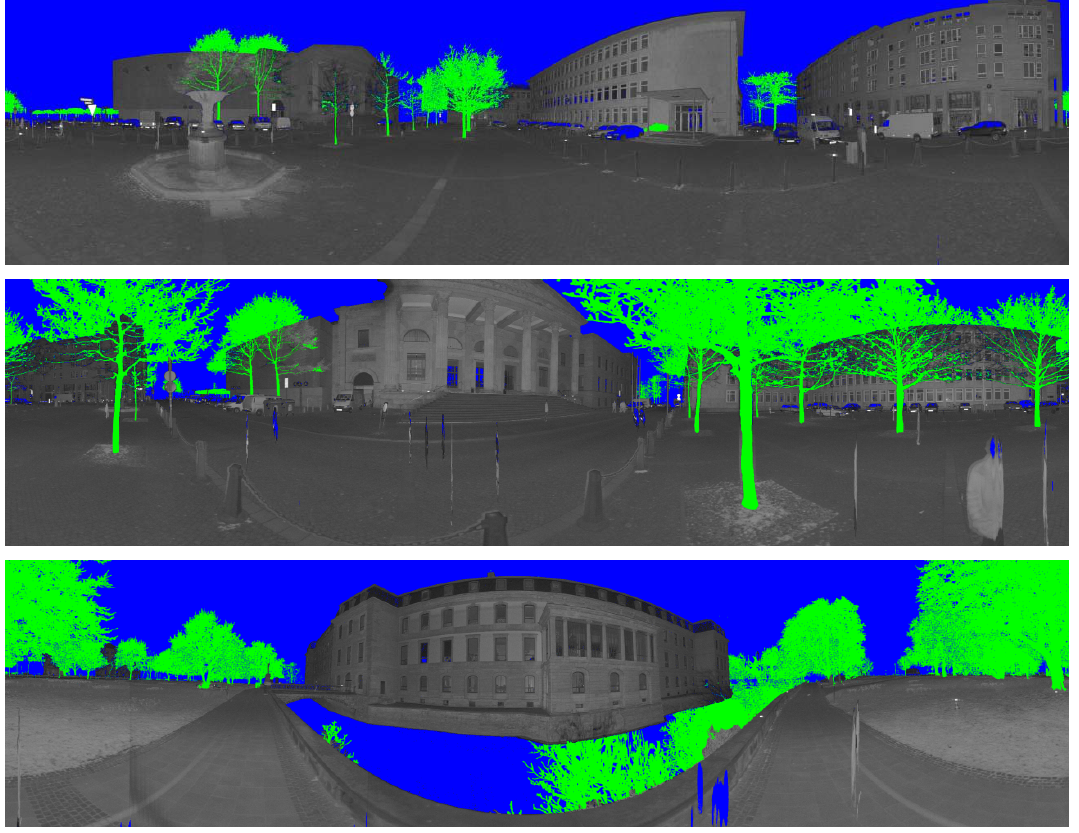
Figure 21. Results of the tree detection scheme applied on scans 3, 5, 23. The denser tree crowns against the sky background (contrasting those against buildings) are due to the last return operation mode of the laser